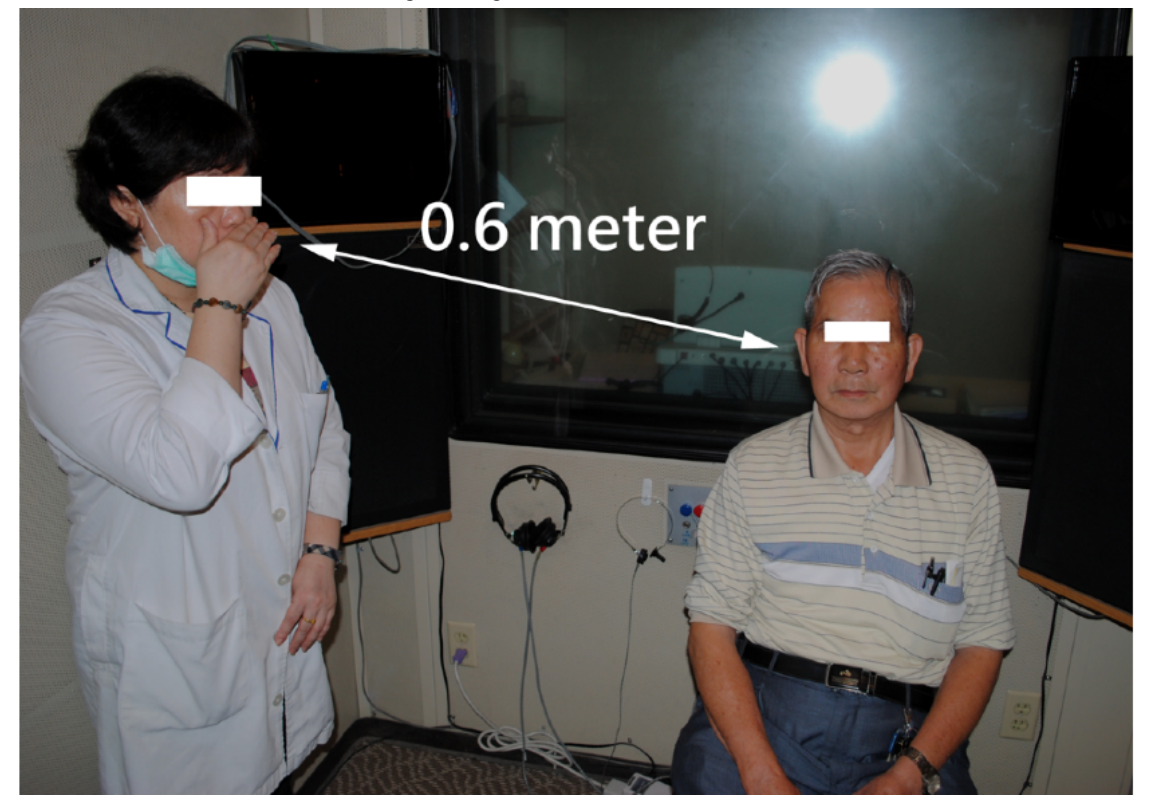
Figure 2. Demonstration of the free-field voice hearing screening test.